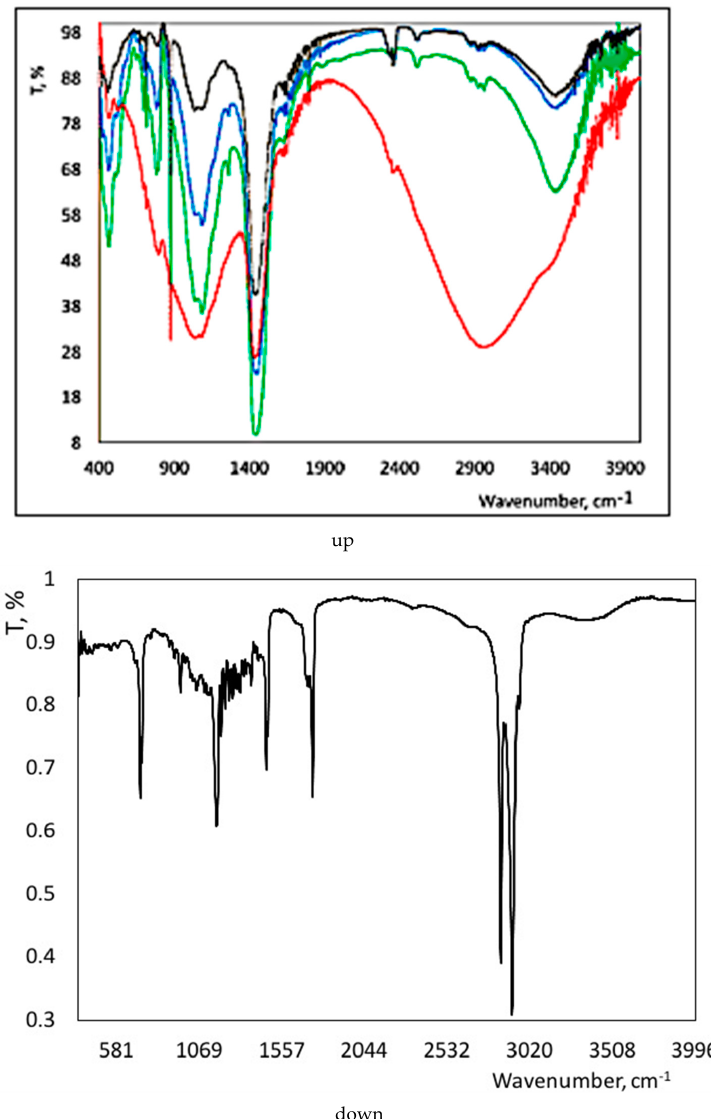
Figure 7. FTIR spectra of the pigments (blue, green and red) ( up ) and beeswax ( down ).